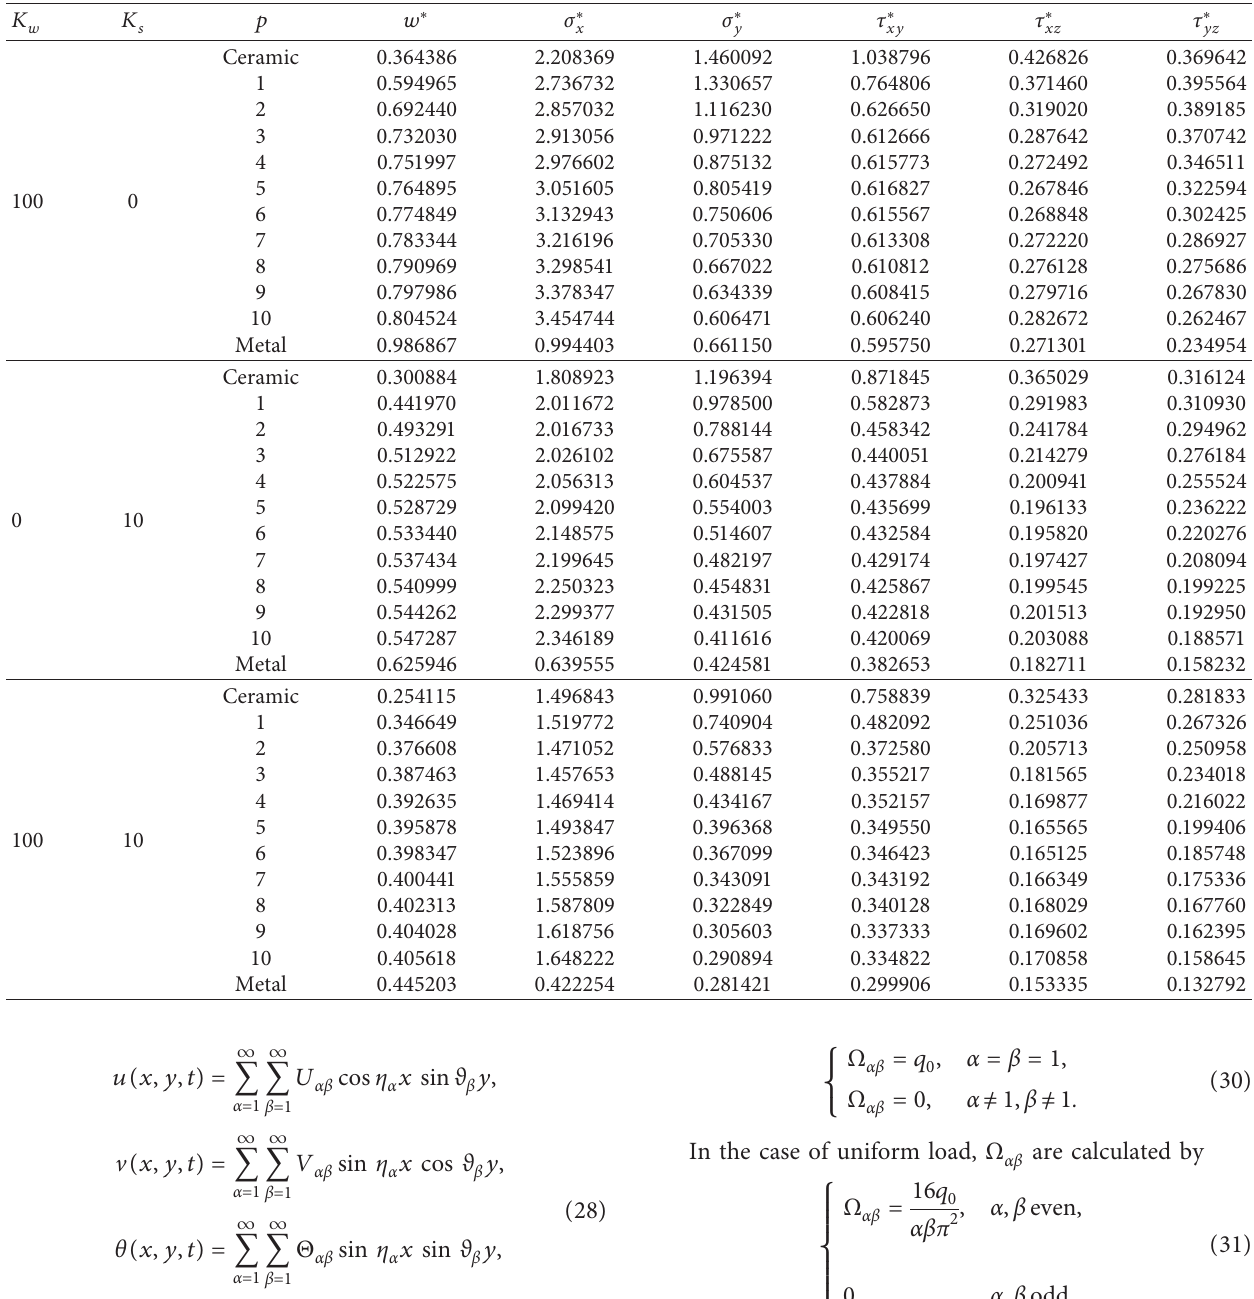
Table 4: The effects of the power-law exponent on the deflection and stresses of the